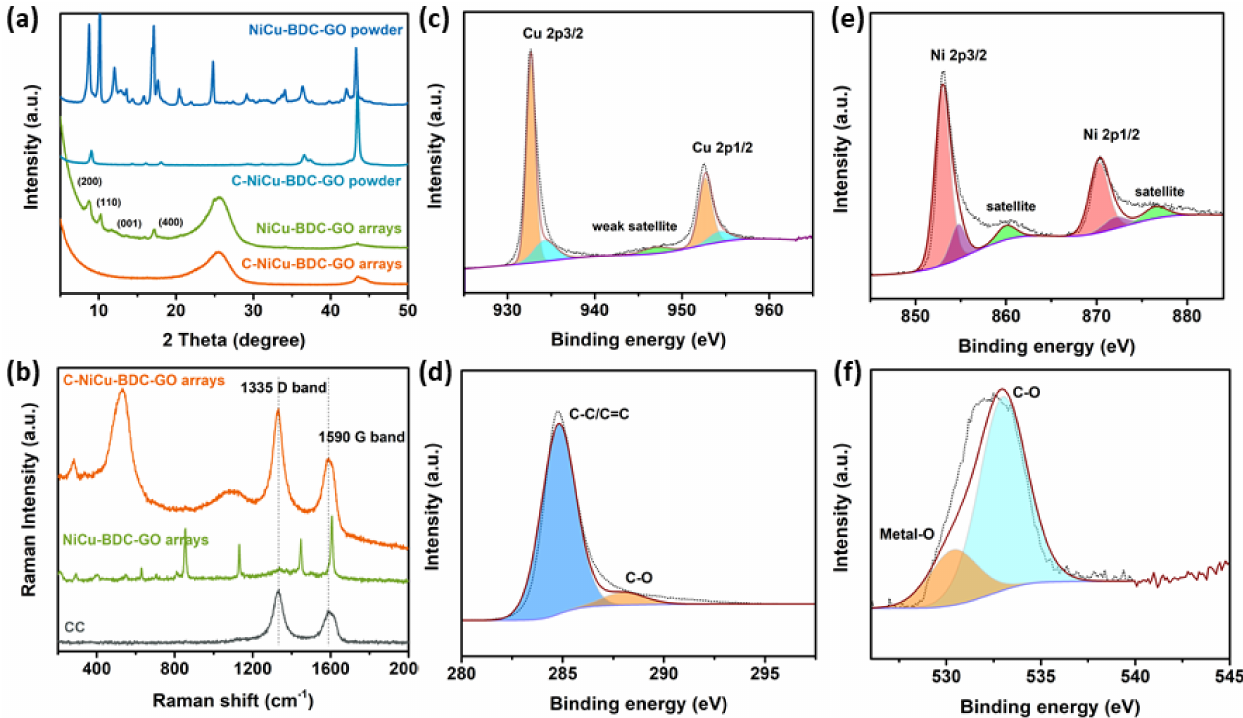
Figure 2. ( a ) XRD patterns of the as-prepared catalyst C–NiCu–MOF arrays and the comparison with C–NiCu–MOF powder; ( b ) Raman spectra of C–NiCu–MOF arrays and powder; ( c ) the fitted peaks corresponded to Cu o and Cu + 2p3/2 (932.6 eV) and 2p1/2 (952.7 eV); ( d ) the fitted peaks corresponded to graphitic carbon (284.8 eV); ( e ) the fitted peaks related to Ni 2+ 2p3/2 (852.9 eV) and 2p1/2 (870.4 eV); ( f ) O 1s (531.1 and 532.9